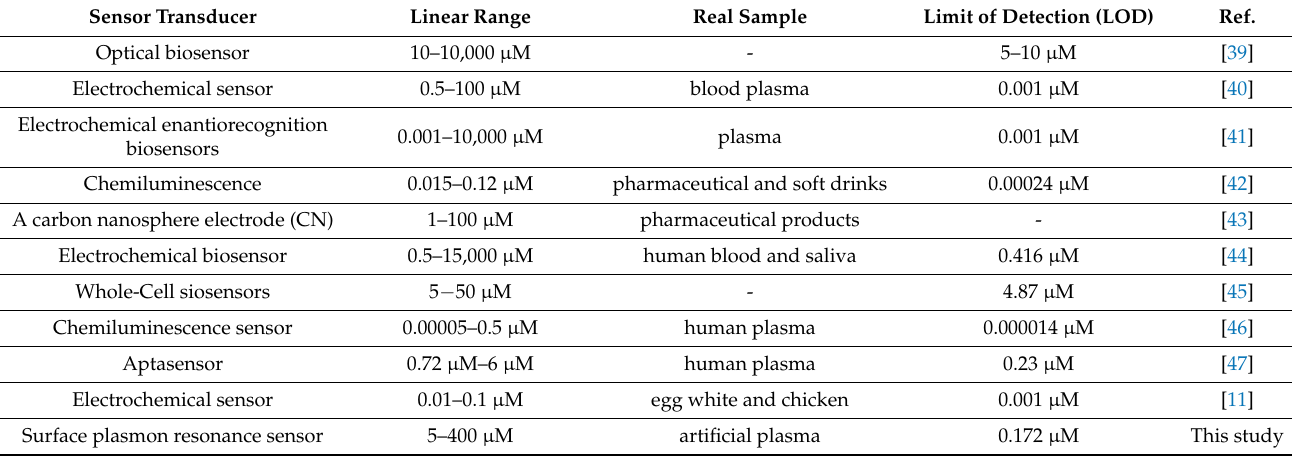
Table 1. The comparison of the prepared sensor system in the literature for determination of L -phenylalanine ( L -Phe). Sensor